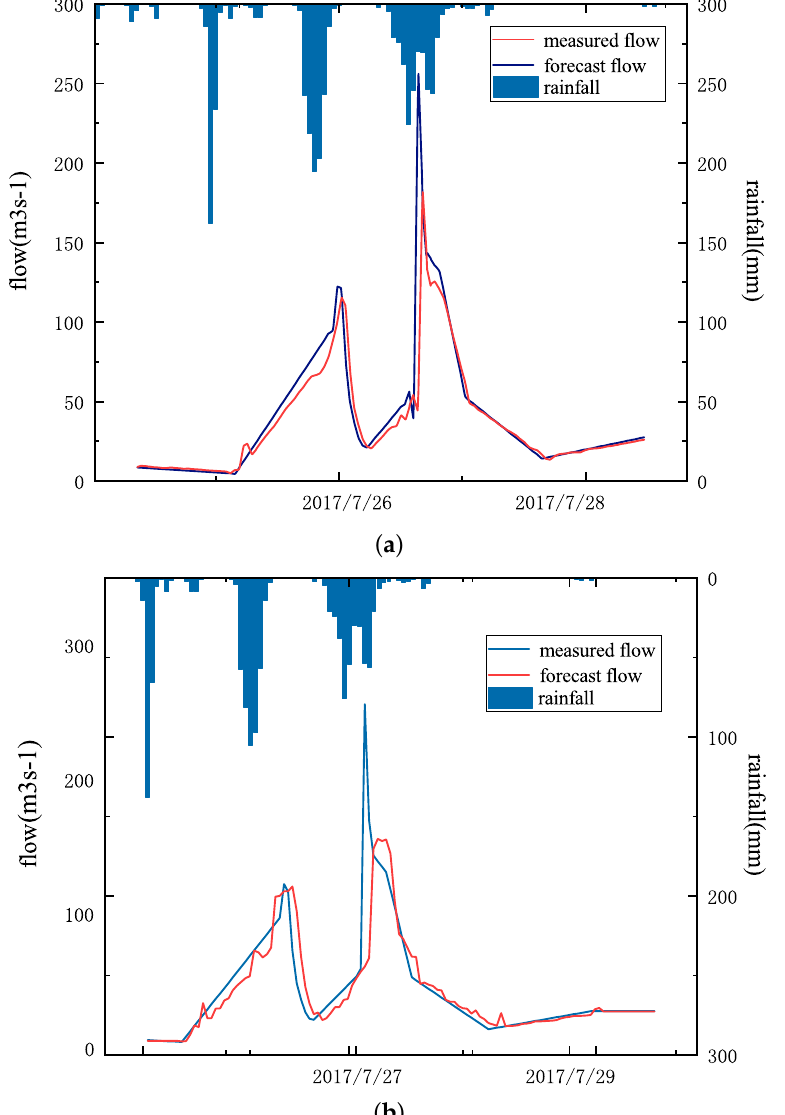
Figure 10. The forecasting process of flood No. 20170727. ( a ) Flood forecast results of the No. 20170727 flood under the BP neural network model. ( b ) Flood forecast results of the No. 20170727 flood under the random forest model. Among them, the blue line is the measured flow at the Zhaishang station, the red line is the predicted flow at the Zhaishang station, and the blue histogram is the rainfall value in the